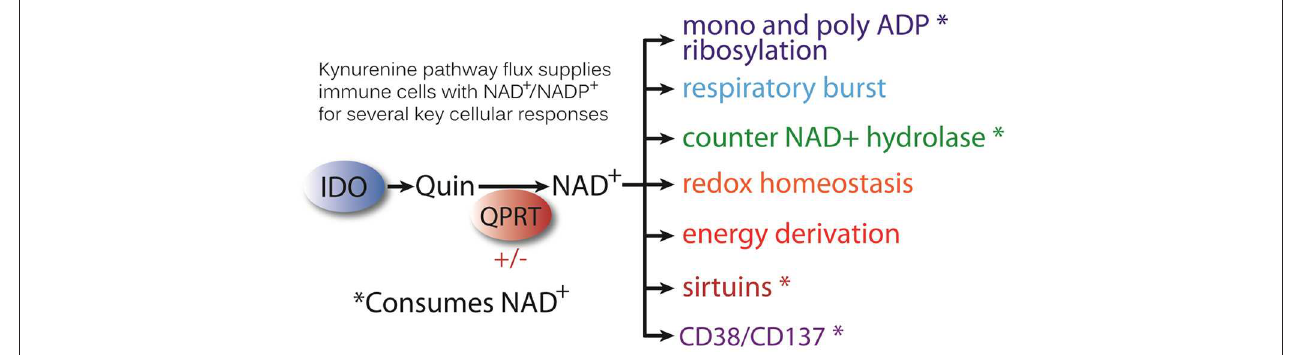
FIGURE 13 | The kynurenine pathway generates immune modulatory agents, but it also supplies Quin to be directed to NAD + synthesis in cells of the immune system. Regulation of the enzyme QPRT controls the flow of kynurenine pathway metabolism to NAD + . Increased NAD + demand during inflammation and infection is driven by a number of cellular actions including energy derivation, the respiratory burst, and cellular redox homeostasis. In addition, there are a number of enzymatic reactions that use NAD + as cosubstrate, and these reactions consume NAD + . These include the PARP reaction for DNA repair (poly-ADP ribosylation) and mono-ADP ribosylases, such as tankerases TNKS1 and 2. Increased NAD + demand may also come from infections by bacteria that employ NAD + hydrolases to deprive phagocytes of intracellular NAD + . NAD + is also consumed by the NAD + -dependent deacetylases known as sirtuins, which regulate metabolism. Certain host enzymes/receptors also have NAD + hydrolase activity including CD38 and CD157, which are ADP-ribosyl cyclases and